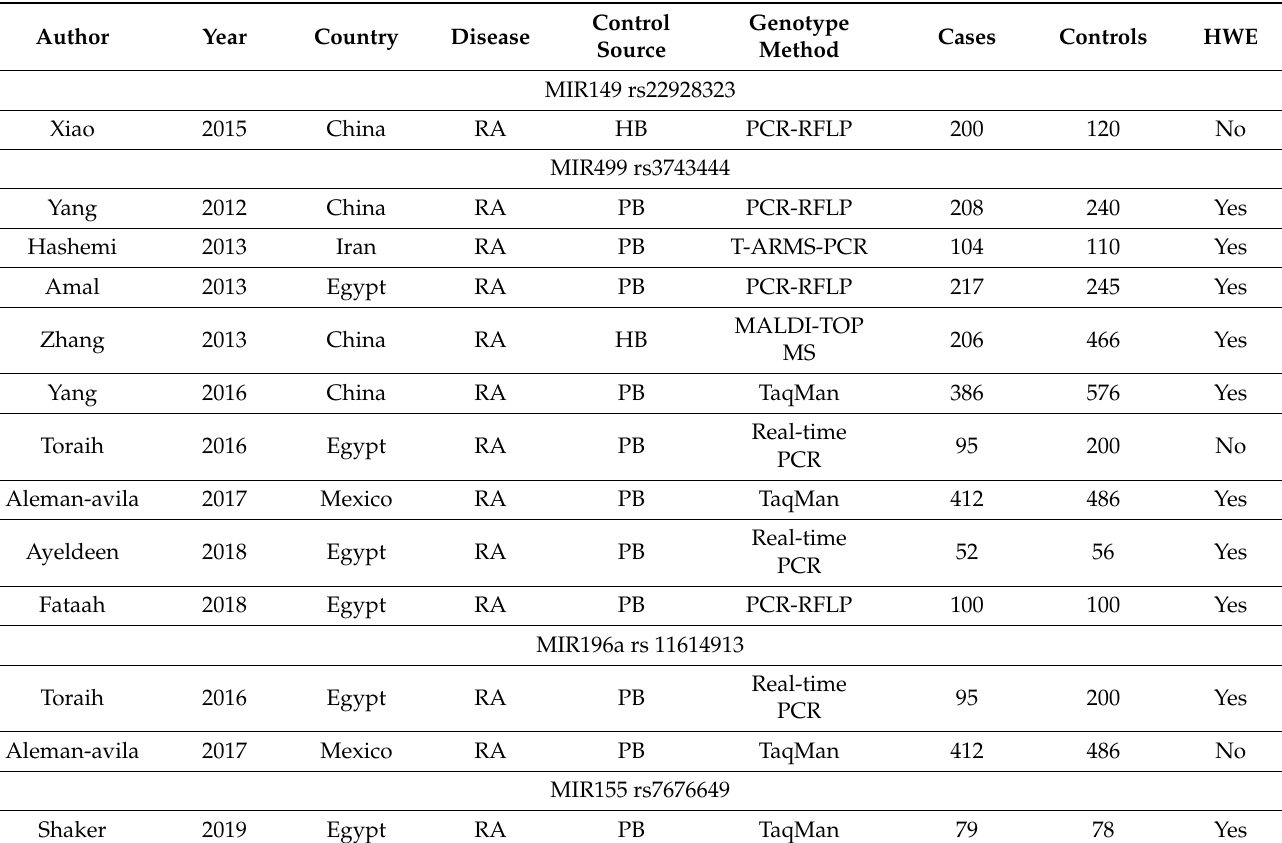
Table 5. The basic characteristics of the retrieved